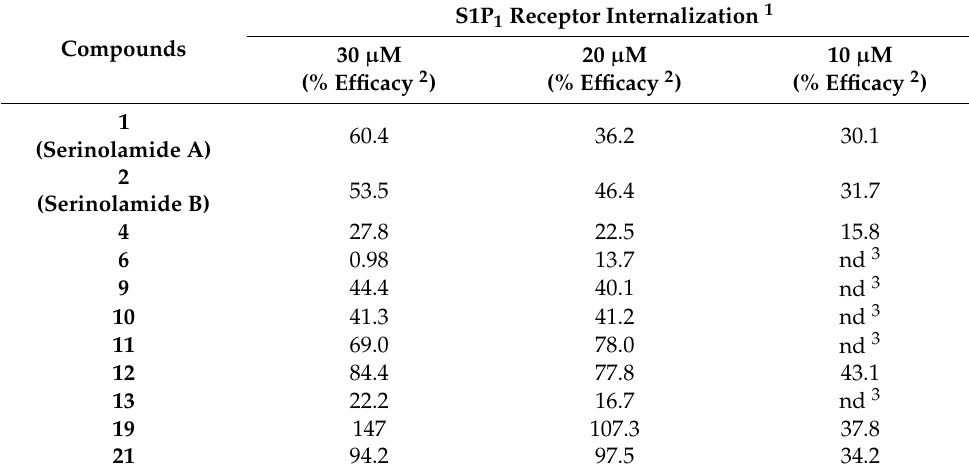
Table 1. Effects of Serinolamide A derivatives on ligand binding to G protein-coupled